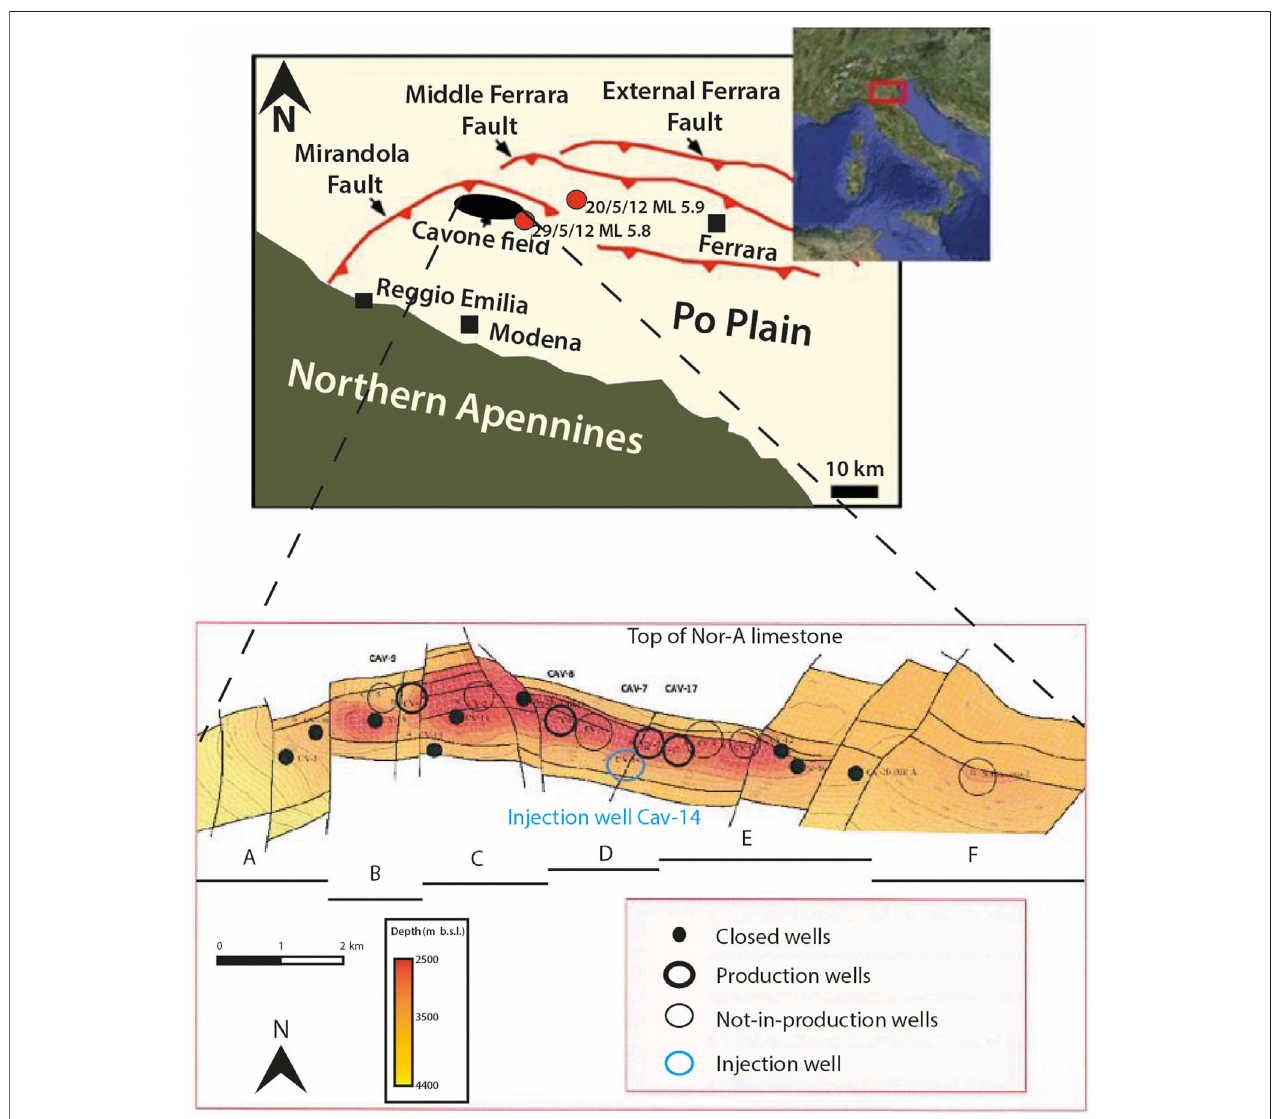
FIGURE1| Toppanel: regionalmapshowinglocationoftheCavoneoil fi eld(theinsethighlightstheareaofinterest alongtheItalianpeninsula),epicentral locations of the two 2012 Emilia mainshocks (red circles), and principal thrust faults from Pieri (1983). Bottom panel (Società Padana Energia personal communication, 2019): letters (A – F) indicate the different blocks of the oil fi eld, identi fi ed by both the tear faults (have an almost N-S strike) and the topography of the Top of Noriglio-A (Nor-A) formation.